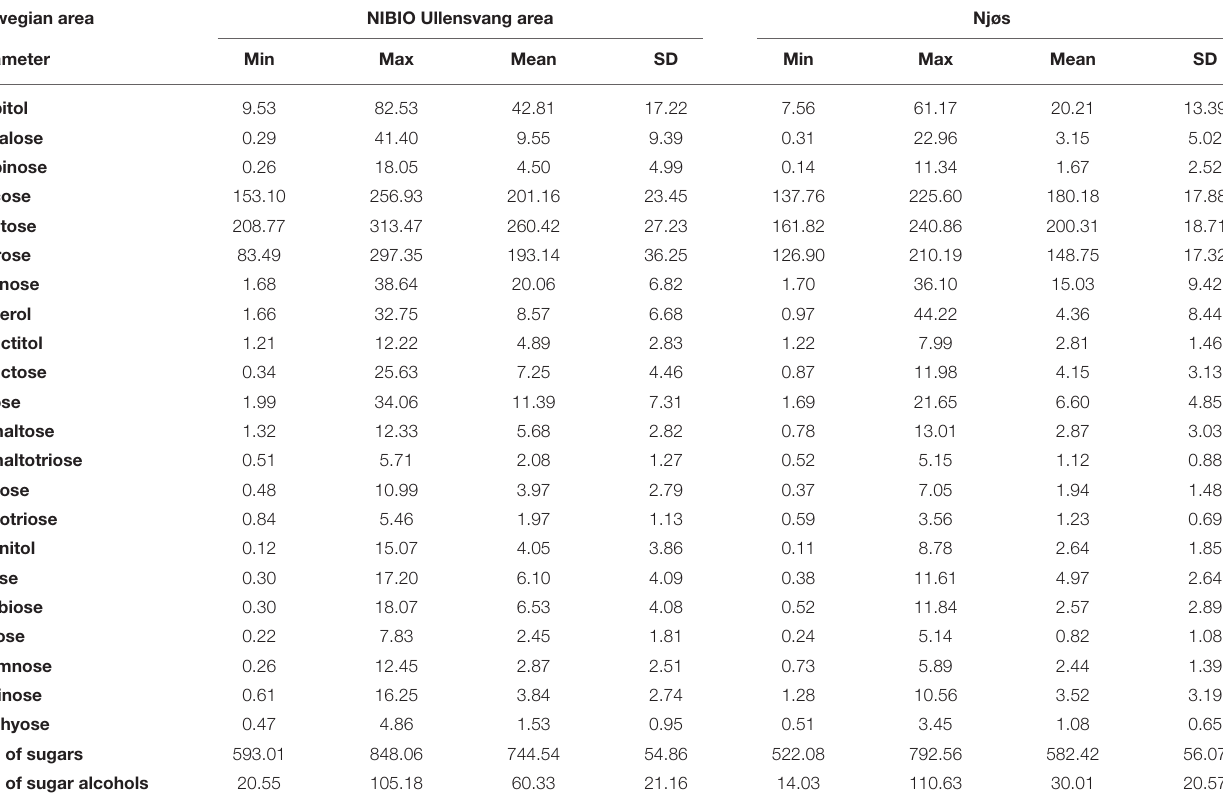
TABLE 1 | Descriptive analysis of sugar content (g/kg dw) in Norwegian apple samples from the NIBIO Ullensvang area (no. 1–74) and from Njøs (no. 75–103) during 2-year harvesting. Norwegian area NIBIO Ullensvang area